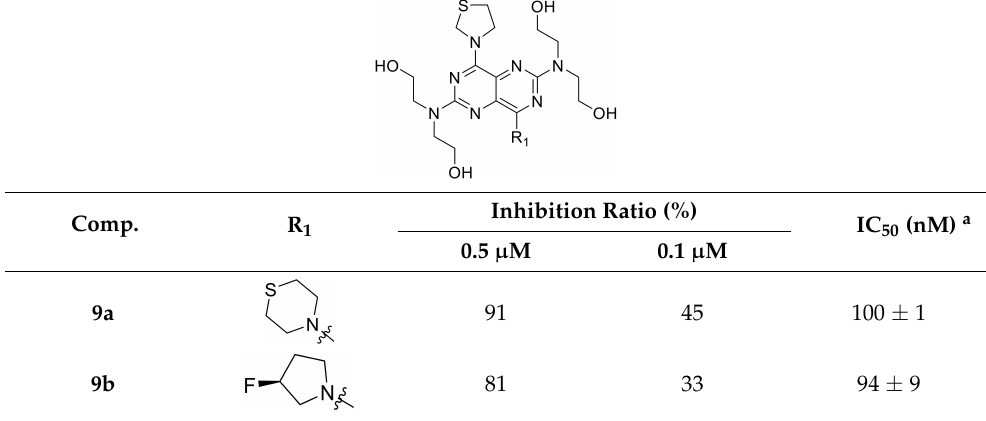
Table 3. The inhibitory activities of target compounds 9a and 9b against PDE5.